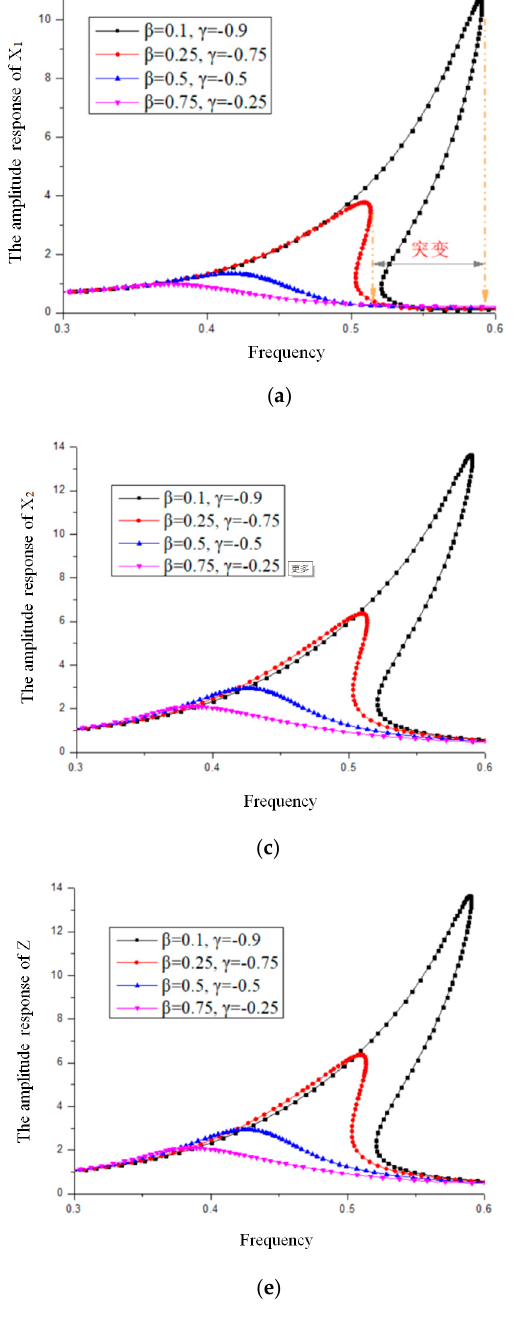
Figure 5. Amplitude–frequency characteristic curve of the isolation structure under different control parameters ( γ ≤ 0) ( a , b ) Amplitude–frequency characteristic curve of the substructure; ( c , d ) Amplitude–frequency characteristic curve of the superstructure; ( e , f ) Amplitude–frequency characteristic curve of the hysteretic element.